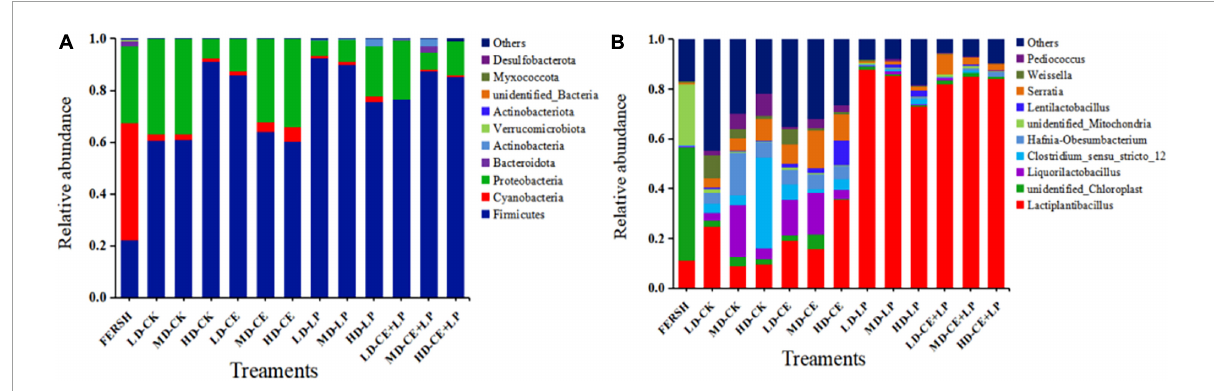
FIGURE3 The relative abundance of bacteria based on the taxonomic classification of the microbial community of oat silage on day 60 identified at (A) the phylum level and genus level (B) . FRESH, fresh sample; LD, the moisture content is approximately 67%; MD, the moisture content is approximately 75%; HD, the moisture content is approximately 81%; CK, control, no additive; LP, L. plantarum ; CE, cellulase; LP+CE, combination of L. plantarum and